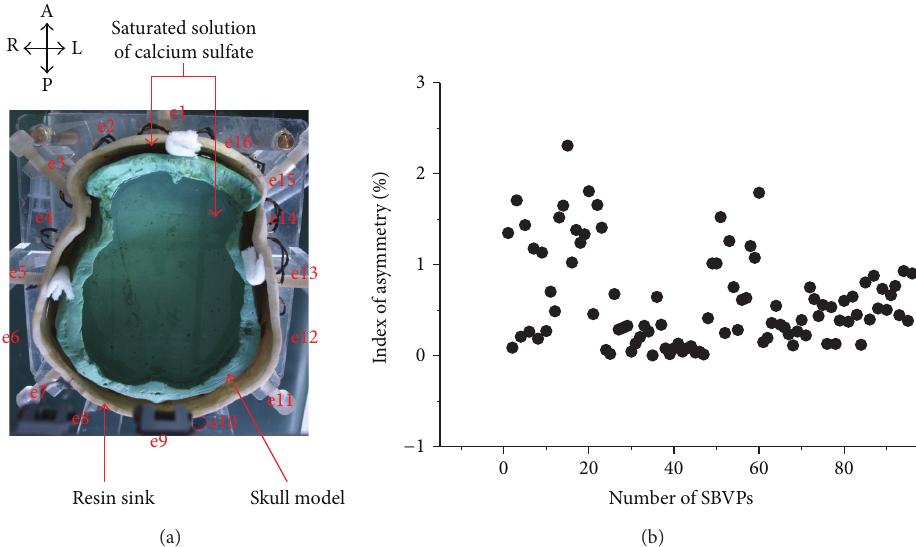
Figure 9: Physical phantom experiments: (a) physical phantom of realistic human head (A: anterior; P: posterior; L: left; and R: right); (b) index of asymmetry (IA) of the physical phantom.